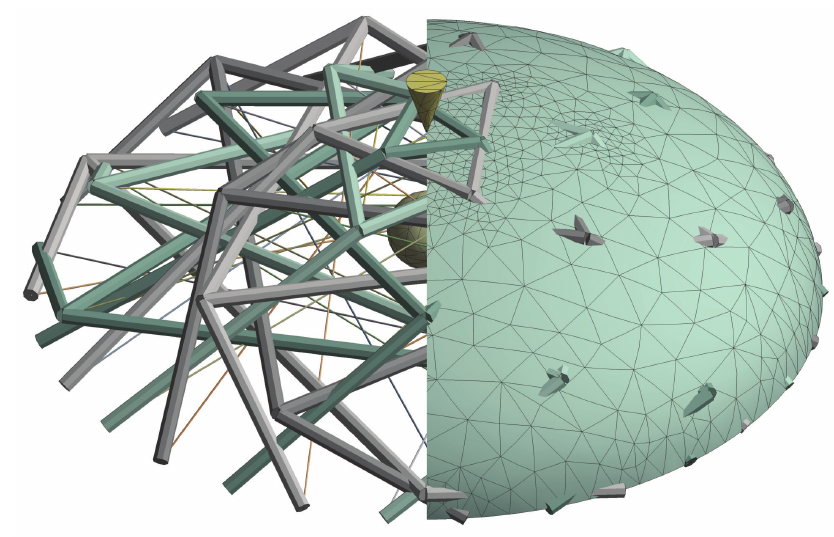
Figure 3. The integrated model of an HEK-293 cell indented by a rigid